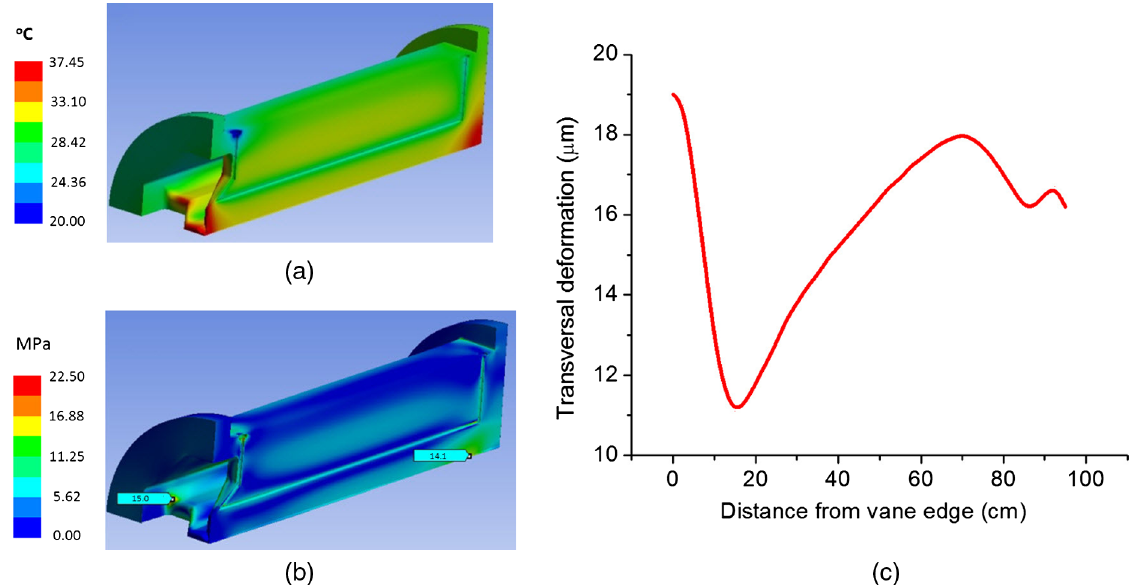
FIG. 14. Results for the final cooling channel